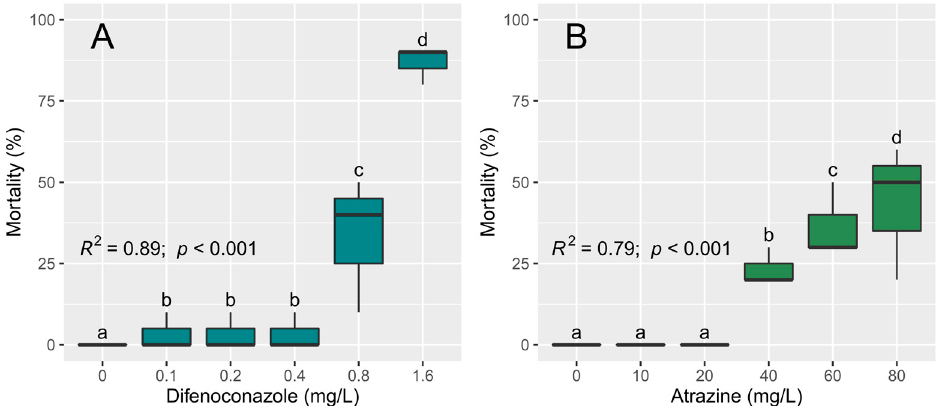
Figure 3. Effects of difenoconazole ( A ) and atrazine ( B ) after 48 h of exposure on the percentage of mortality of Daphnia magna . Different lowercase letters denote significant differences in the means at p ≤ 0.05 (pairwise comparisons) between different pesticide concentrations.